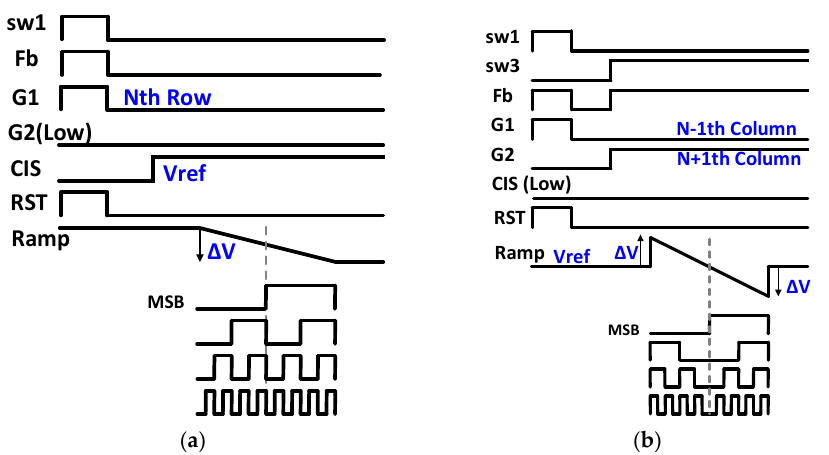
Figure 8. Timing diagrams of ( a ) the conventional CIS operation and ( b ) edge detection operation.